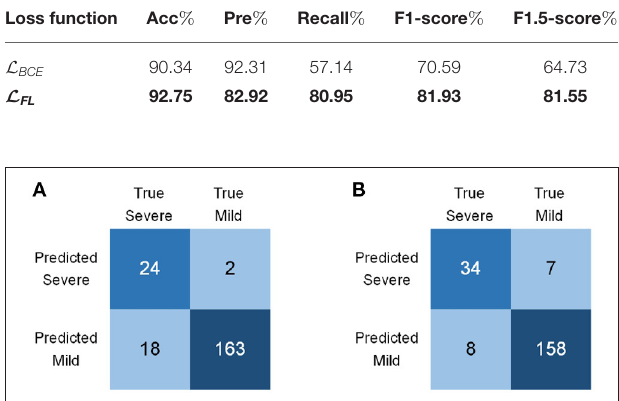
FIGURE 8 | Confuse Matrices of different loss functions. (A) BCE Loss model. (B) Focal Loss